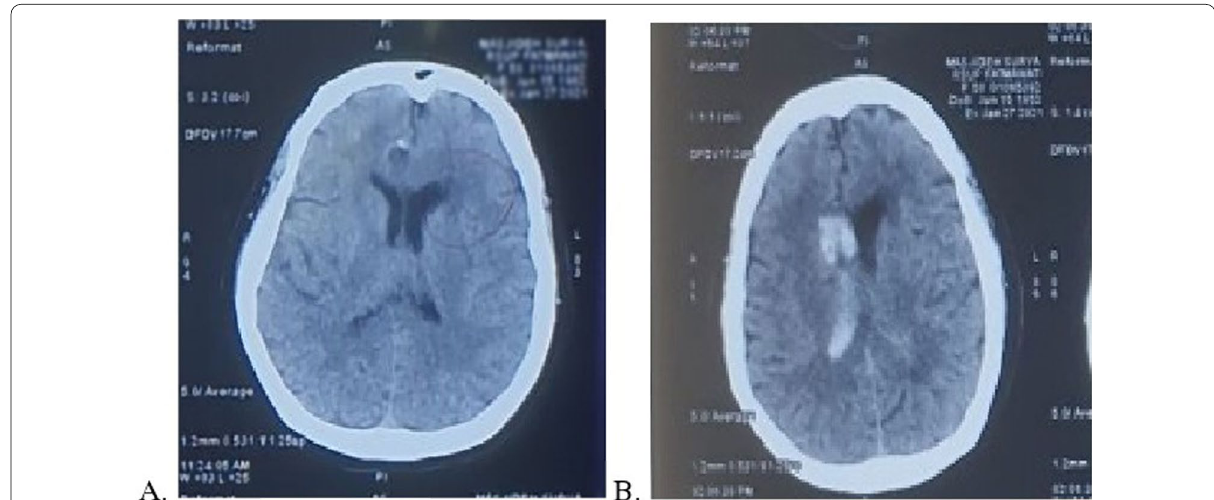
Fig. 2 Head CT Scan A Before thrombolysis showed infarct in capsula eksterna sinistra cornu anterior, B After thrombolysis showed bleeding in lateral ventricle bilateral especially in the right and third